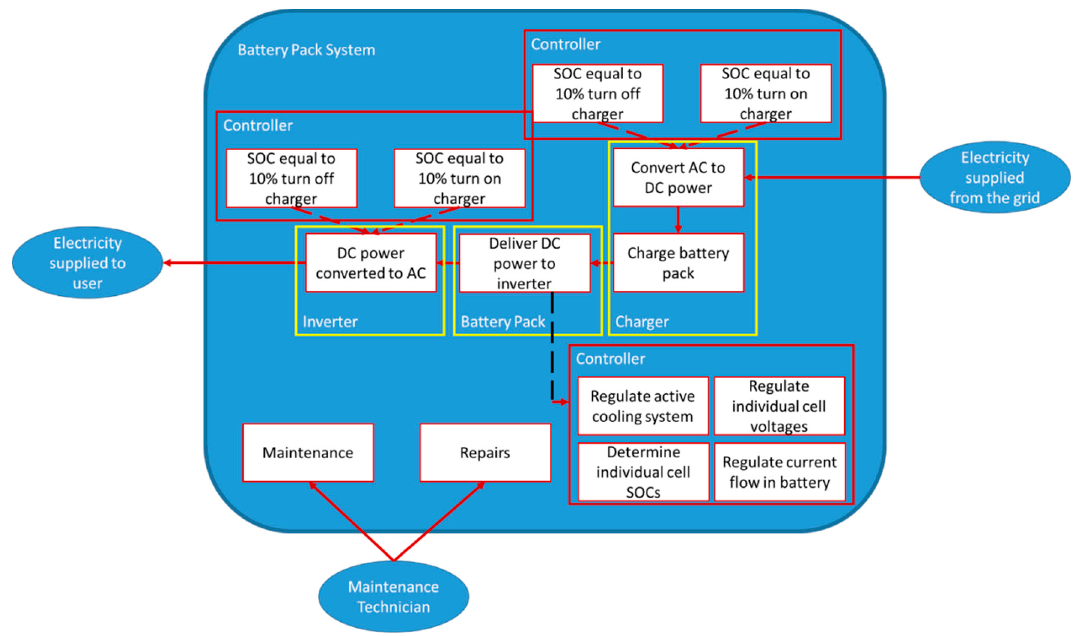
Figure 6. Use case diagram for a re-purposed battery pack system.